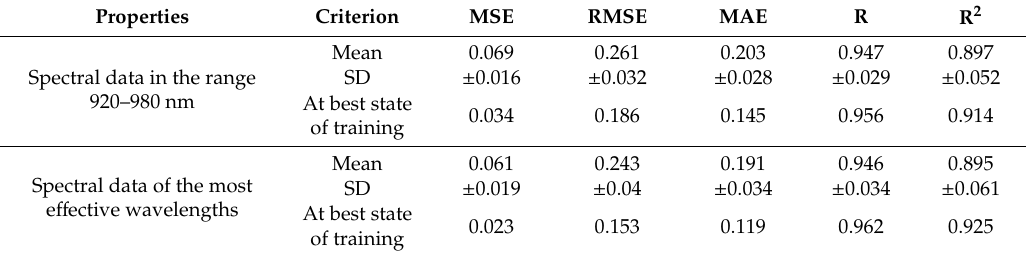
Figure 12. Regression analysis of scatter plot at the best state of training of ANN-BBO to predict starch content of Fuji apple. ( a ) Based on spectral data in the range of 920–980 nm, ( b ) of the most effective wavelengths. Table 4. Comparison of the mean and standard deviation of criteria of ANN-BBO for estimating TSS of Fuji apple in 100 replicates using spectral data of 920–980 nm and data on effective wavelengths.